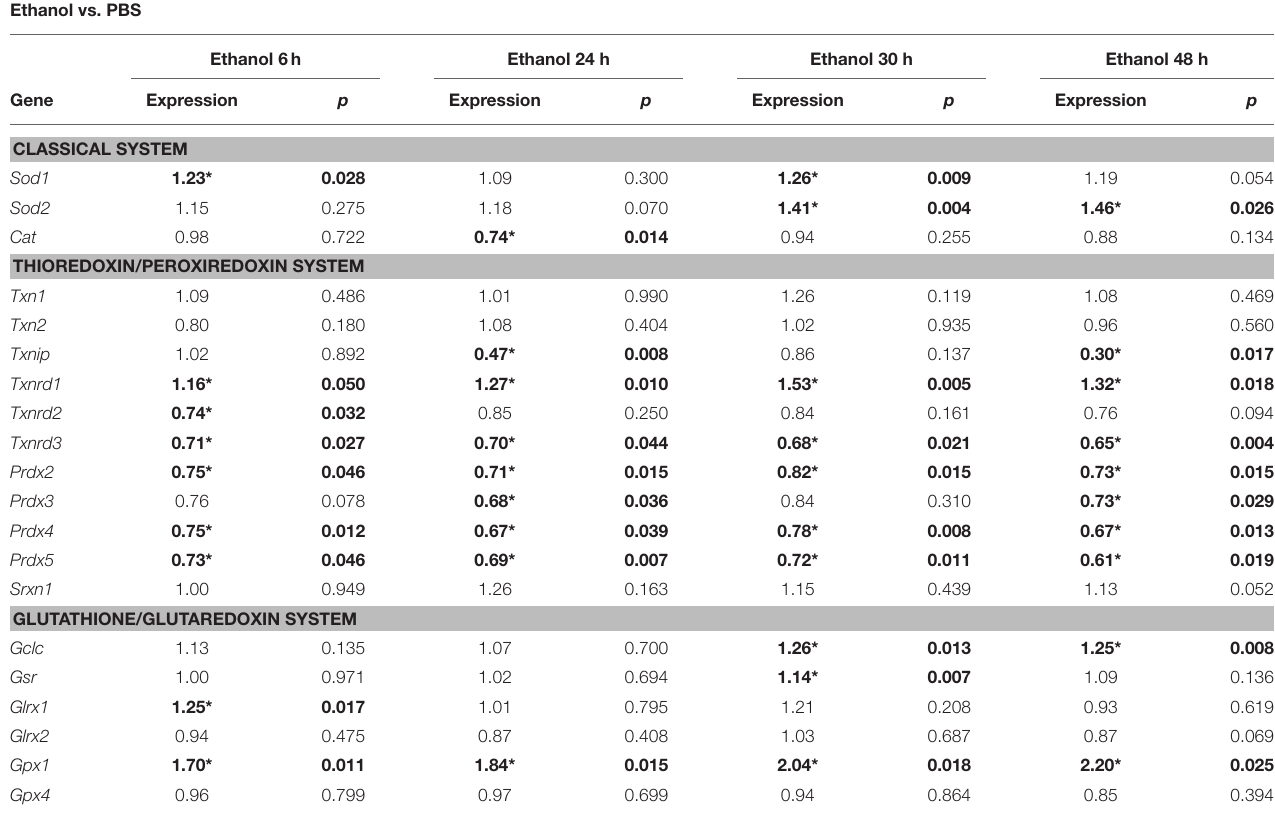
TABLE 2 | Gene expression of antioxidant systems in HT22 cells exposed to ethanol (0.1%) or PBS. Ethanol vs.